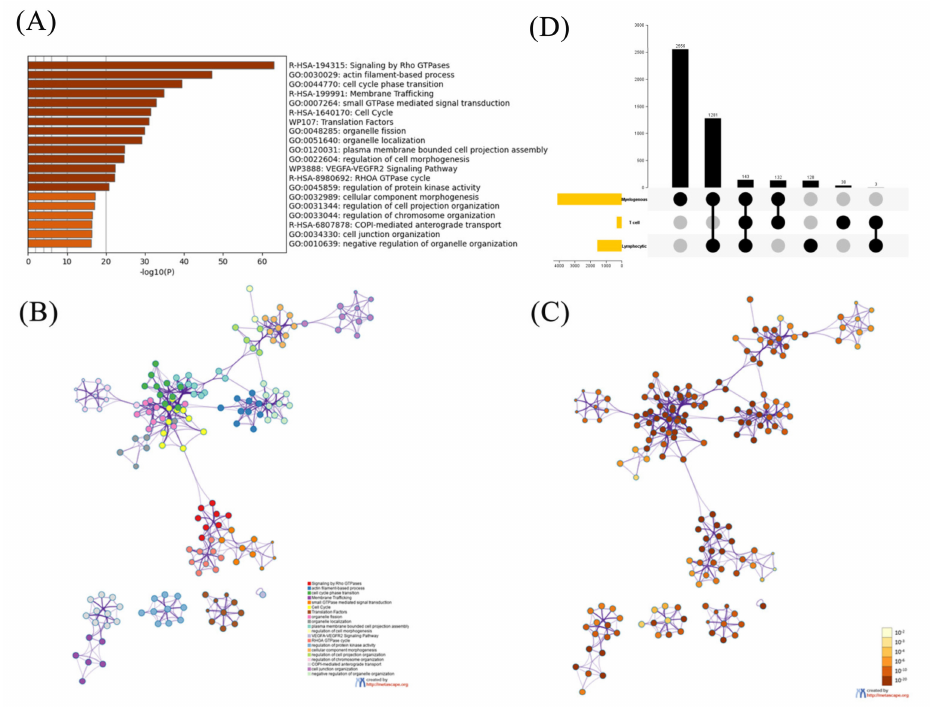
Figure 1. Top 20 clusters with their representative enriched terms (one per cluster) of genes which have leukemia-related phosphorylation sites. ( A ) Heatmap of p -value for each cluster. ( B ) The networks of enriched terms with nodes colored by cluster ID, where nodes sharing the same cluster ID are typically close to each other. The most statistically significant term within a cluster is chosen to represent the cluster. ( C ) The network with nodes colored by p -values, where terms containing more genes tend to have a more significant p -value. ( D ) Statistics on the number of different types of leukemia